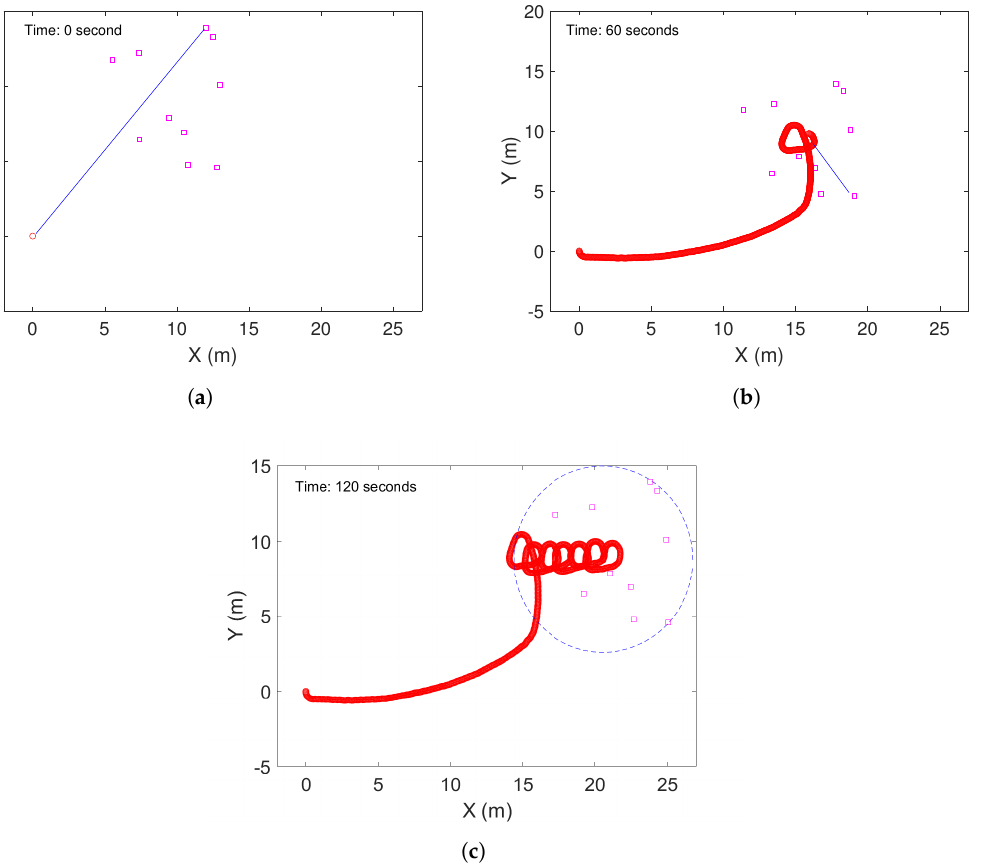
Figure 7. The simulation result with 10 mobile targets. ( a ) The initial condition. ( b ) The robot trajectory and targets’ positions at 60 s. ( c ) The robot trajectory and targets’ positions at 120 s.